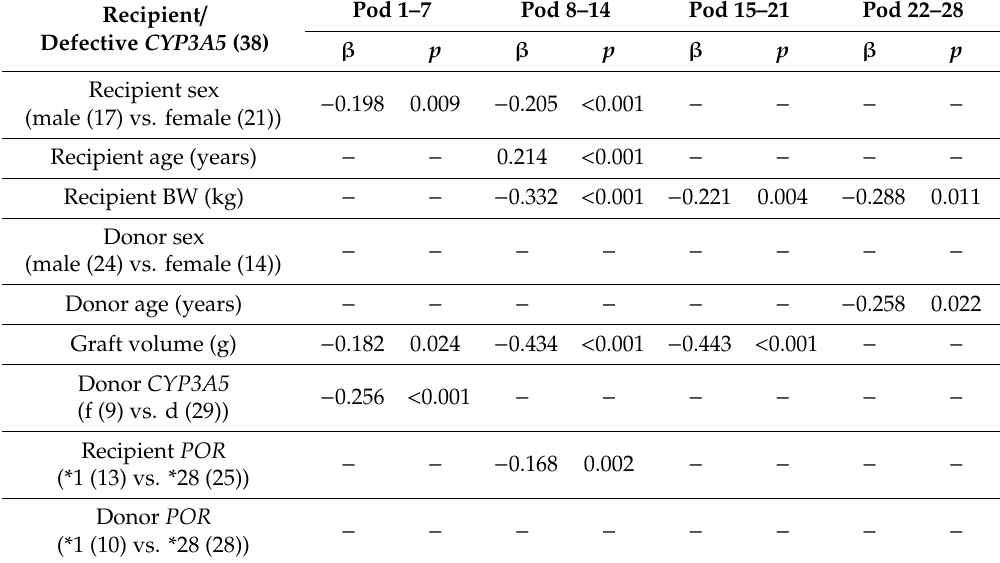
Table 7. Multiple regression analysis of cases in which recipients had defective